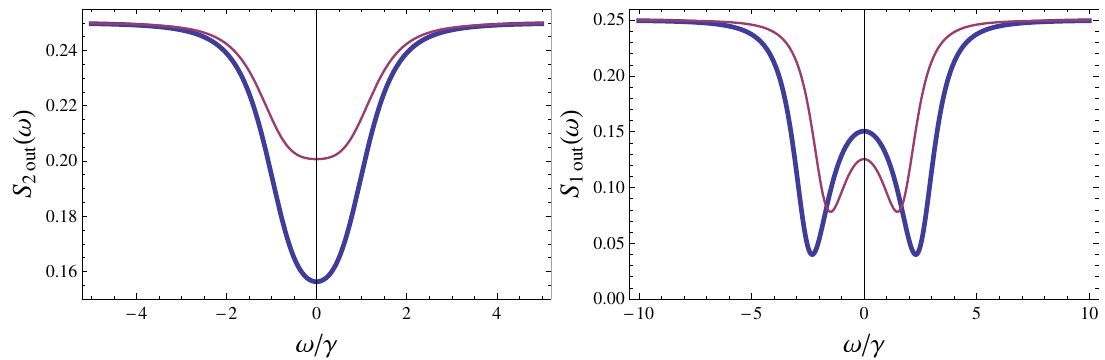
= 0 . 05 γ 0 = 1 . 2 γ (thick line), α = 2 . 1 . 0